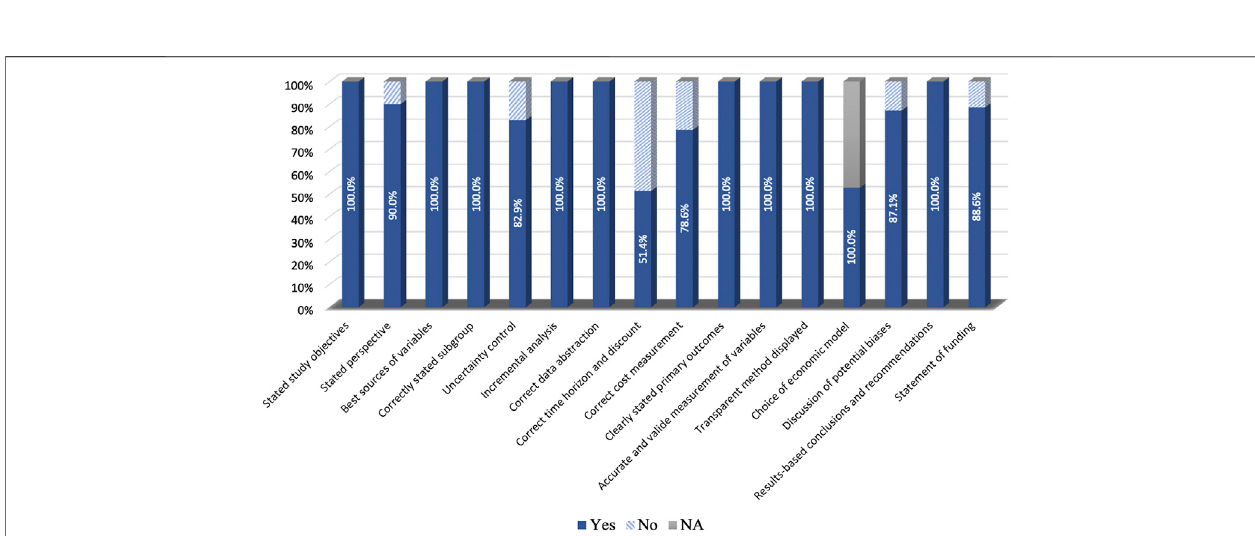
FIGURE 6 | Differences in cost sources between real-world cost-effectiveness analysis with or without decision-analytic model.